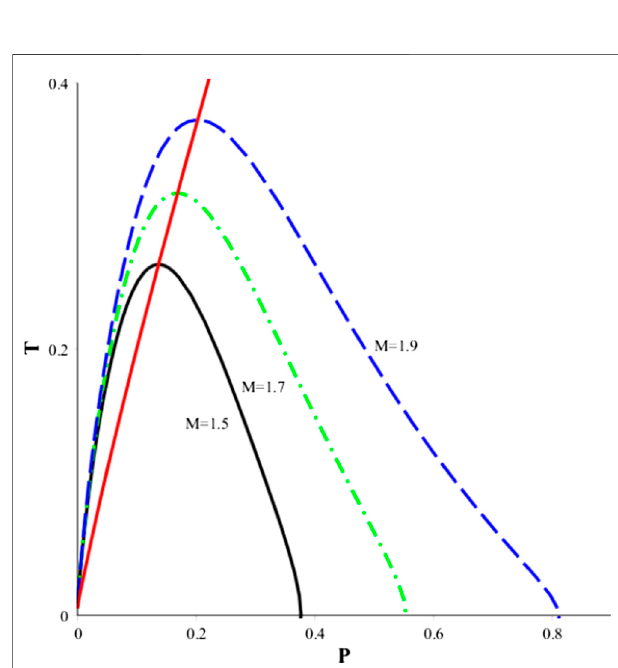
FIGURE 4 | Isenthalpic curves and inversion curve of the BI quasitopological black hole with (cid:5) μ 2 (cid:1) 0 . 1, (cid:5) μ 3 (cid:1) 0 . 1, (cid:5) μ 4 (cid:1) 0 . 001, k (cid:1) 1 and n (cid:1) 4 (A) Q (cid:1) 3, β (cid:1) 10; (B) Q (cid:1) 3, β (cid:1) 1; (C) Q (cid:1) 1, β (cid:1) 1.